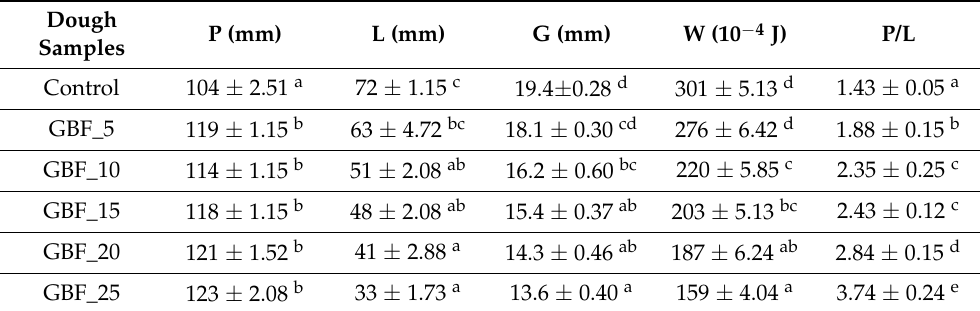
Table 2. Alveograph parameters of the dough samples with different levels of germinated bean flour (BGF) additions.